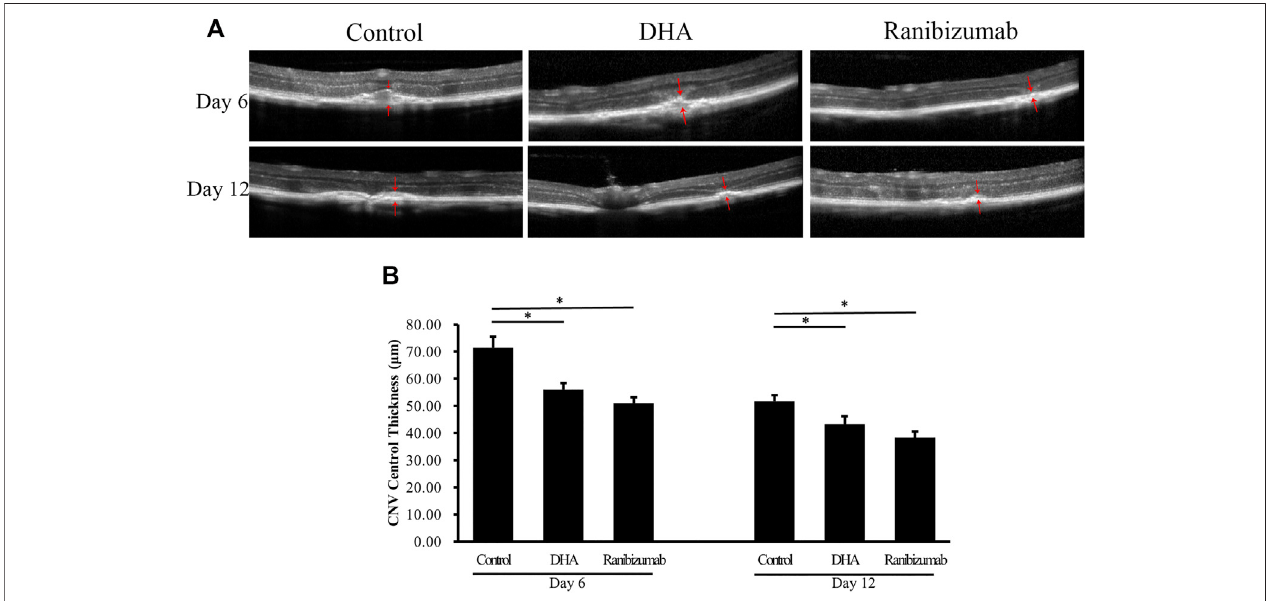
FIGURE 3 | The effect of DHA on CNV central thickness (CCT) examined by SD-OCT images. The CCT of the spindle-shaped CNV lesion is outlined by the red arrows. (A) RepresentativeSD-OCTimagesofCNVinmiceadministered vehicle,DHA,orranibizumab.Scalebar,50 μ m. (B) Comparedtothatinthevehiclegroup,the CCTdecreasedsigni fi cantlywithDHAorranibizumab treatment.Datawereanalyzedbyone-wayANOVAfollowedbyTukey ’ smultiplecomparisonstest.* p < .05.CNV: Choroidal Neovascularization; DHA: